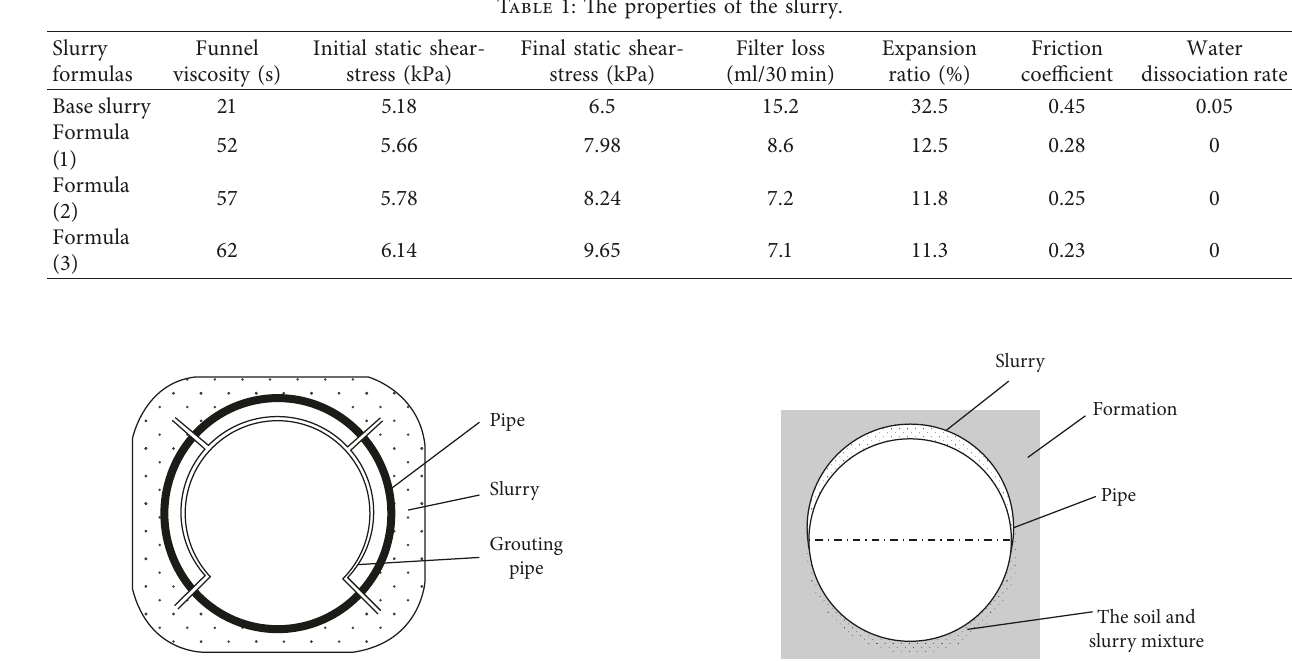
Figure 7: The schematic diagram of grouting in pipe jacking. Figure